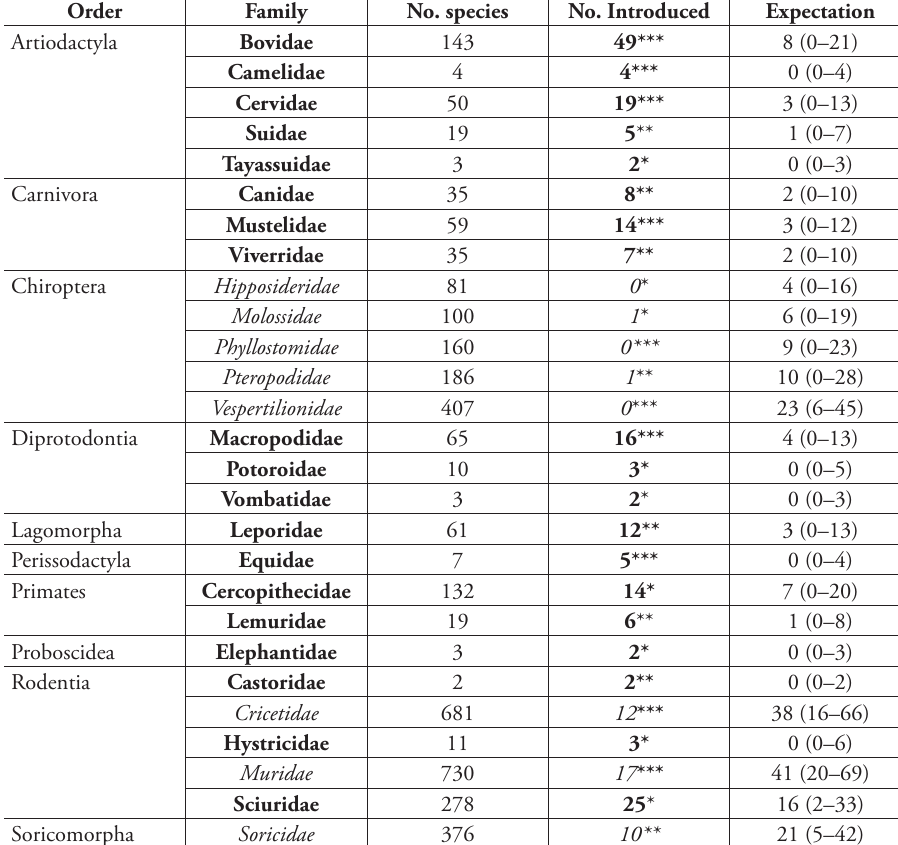
Table 3. The distribution, across mammal families, of all mammal species (No. species), introduced mammal species (No. introduced), and the expected number of introduced species per family (median and range, based on 100,000 iterations of the permutation test) assuming that mammal species were selected for introduction at random (Expectation). Species numbers are based on the taxonomy in Wilson and Reeder (2005). Only families with significantly more (in bold) or fewer (in italics) introduced species than expected by chance are